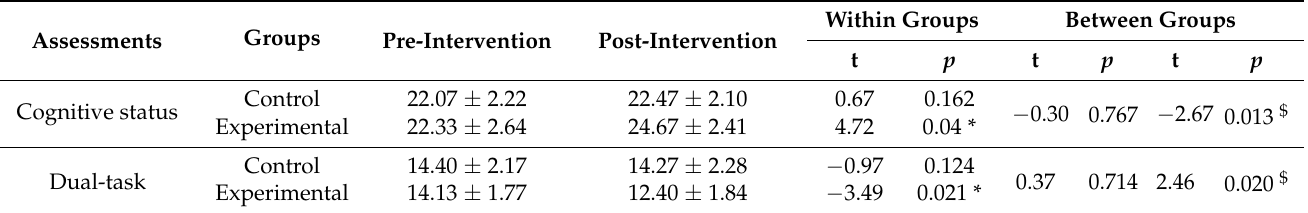
Table 1. Results of paired and independent t -test for cognitive tests and dual-task